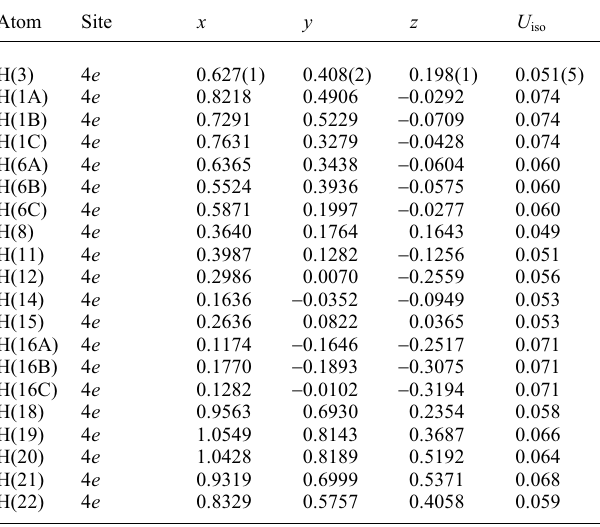
Table 2. Atomic coordinates and displacement parameters (in Å 2 )